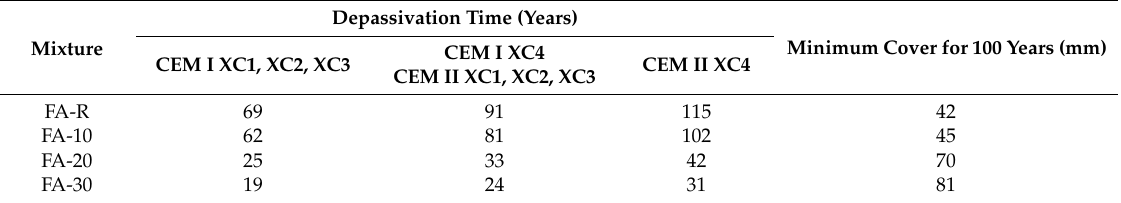
Figure 16. Prediction of service life according to the results of carbonation. Table 7. Estimated depassivation time and minimum cover